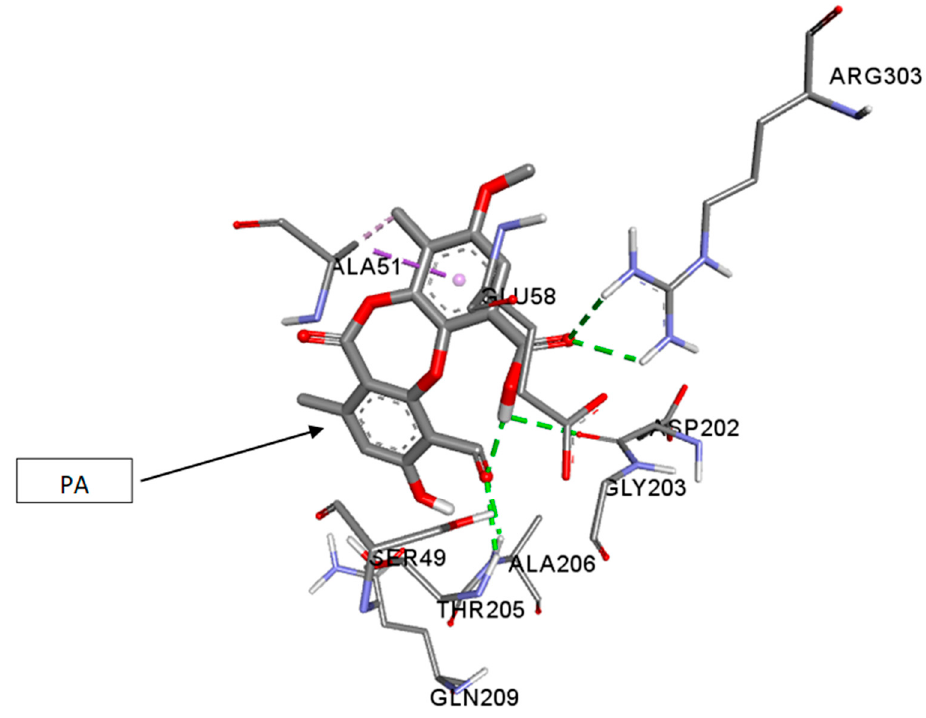
Figure 1. Three-dimensional (3D) interaction diagram of psoromic acid (PA) in the active site of the UDP-galactopyranose mutase enzyme (UGM).